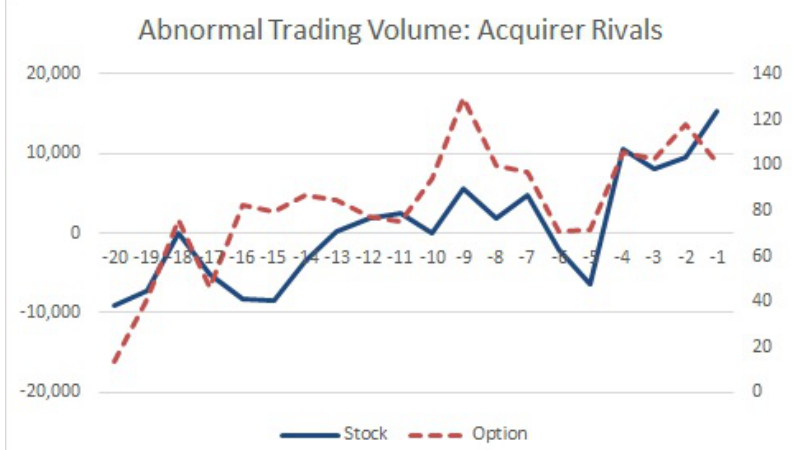
Figure 3. Stock and Option represent the average daily abnormal trading volume of the stocks and options over the 20-day period prior to the announcement for acquirer rivals,